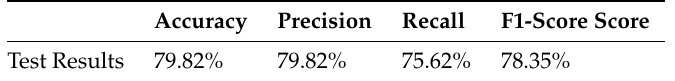
Table 19. Evaluation results of the model trained by CNN using measurements without light.